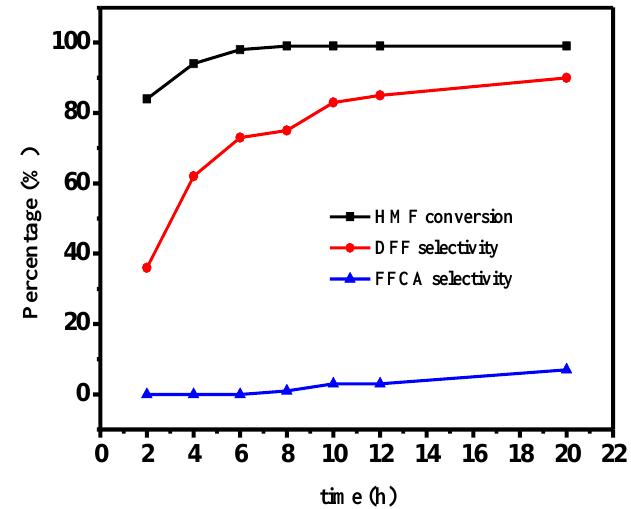
Figure 4. Effects of the reaction time on the oxidation of HMF to DFF. HMF (25.2 mg, 0.2 mmol), VPO/P-C (10 mg), and DMSO (2 mL) at 120 °C in air.